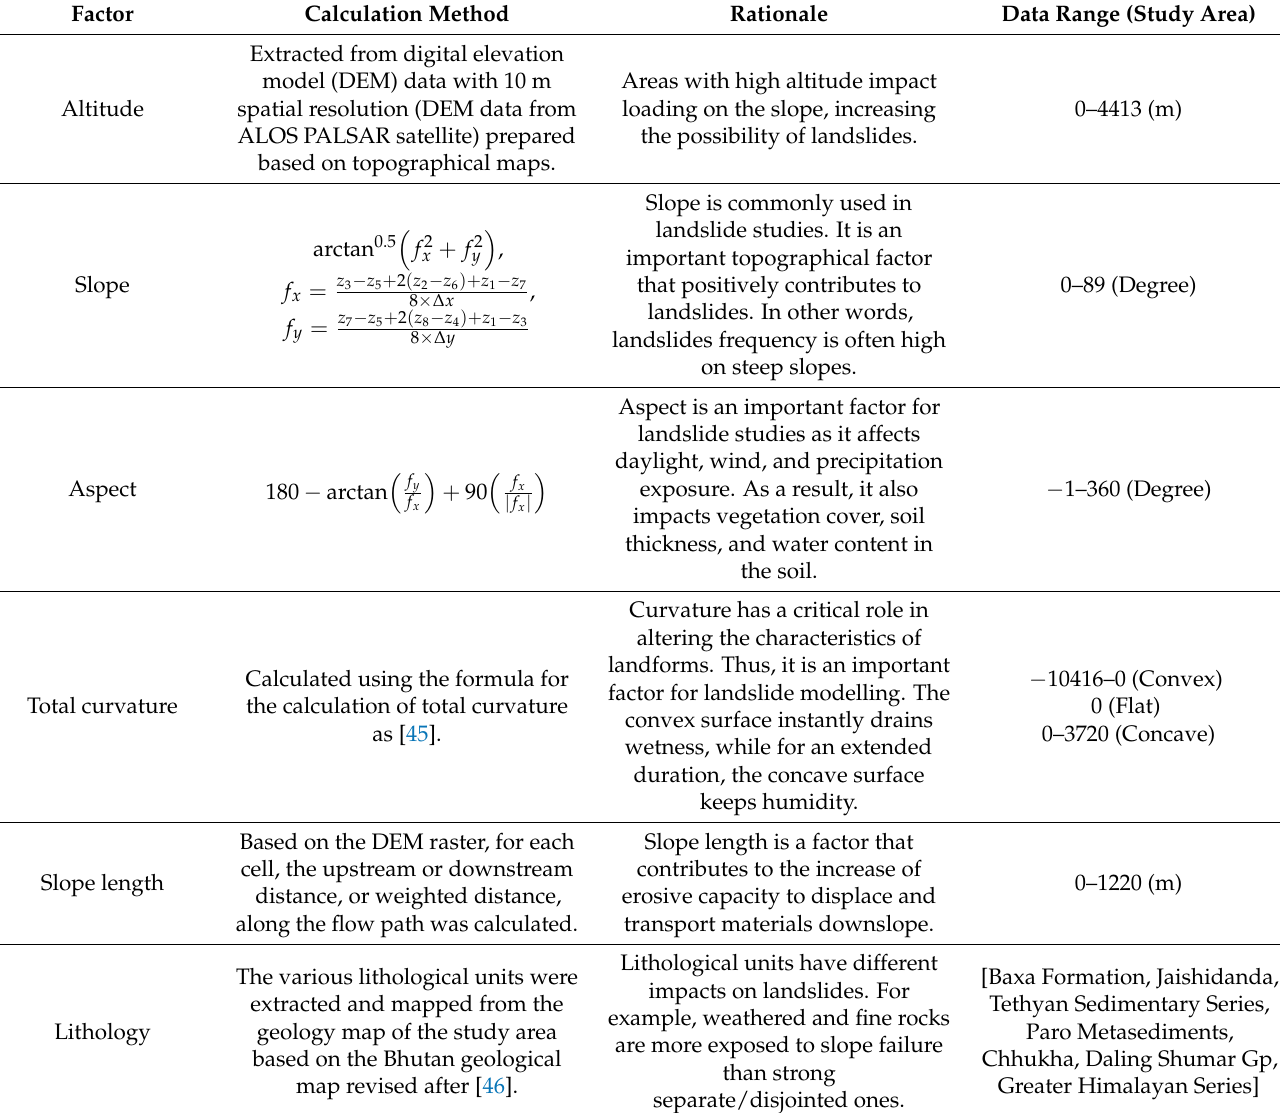
Table 1. List of landslide conditioning factors used in this